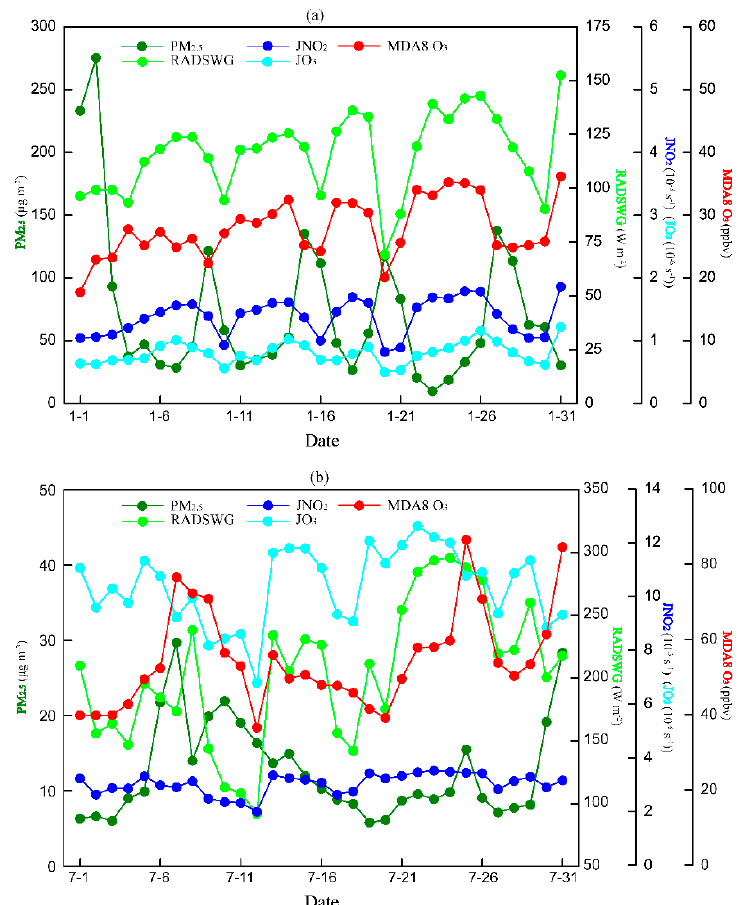
Figure 5. Time-series of simulated daily PM 2.5 concentrations, solar radiation at the ground (RADSWG), photolysis rates (J(NO 2 ) and J(O 3 )), and MDA8 O 3 concentrations for ( a ) Beijing–Tianjin–Hebei (BTH) in January and ( b ) Pearl River Delta (PRD) in July.